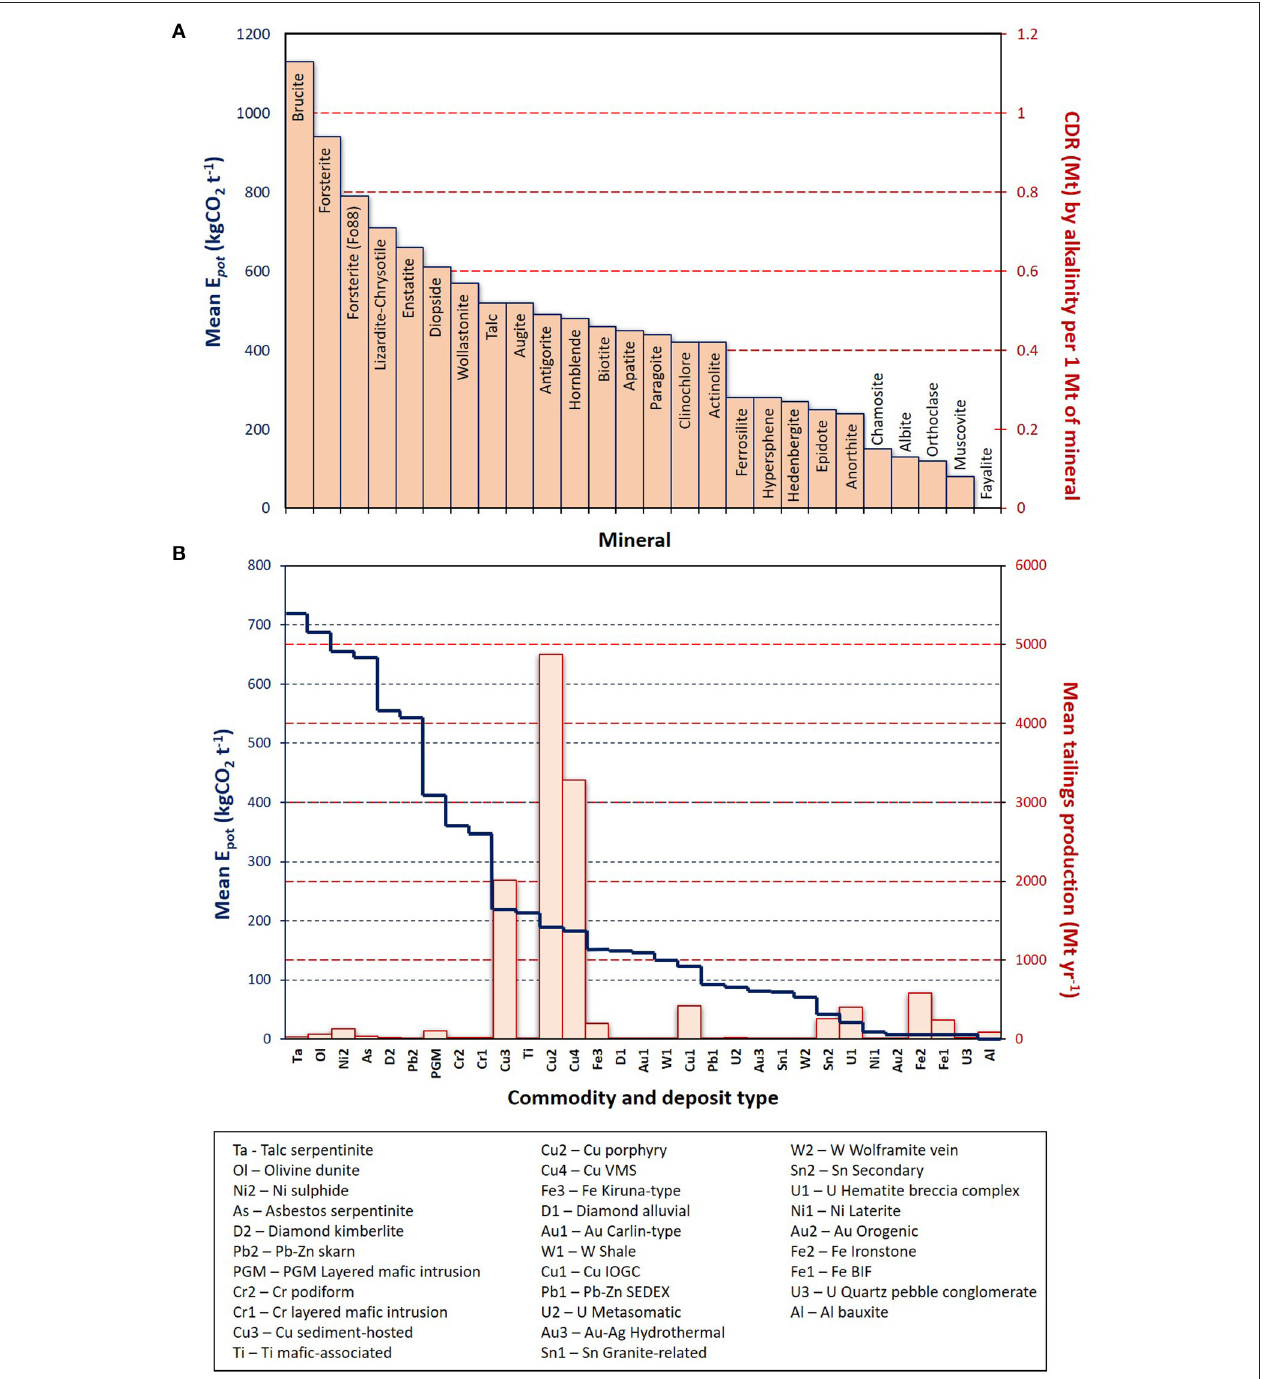
FIGURE 2 | Production tonnages and enhanced weathering potential (E pot ) of deposit types and associated common rock-forming minerals. (A) Calculated E pot of common minerals and major gangue minerals likely to be present in tailings. CO 2 captured as alkalinity per 1 Mt of each mineral also shown. (B) Mean E pot values of commodity-hosting deposit types (blue line) and mean estimated tailings production (red bars) from major commodity-hosting deposit types. Data and explanation of abbreviations are provided in Supplementary Material 3 – 6 .